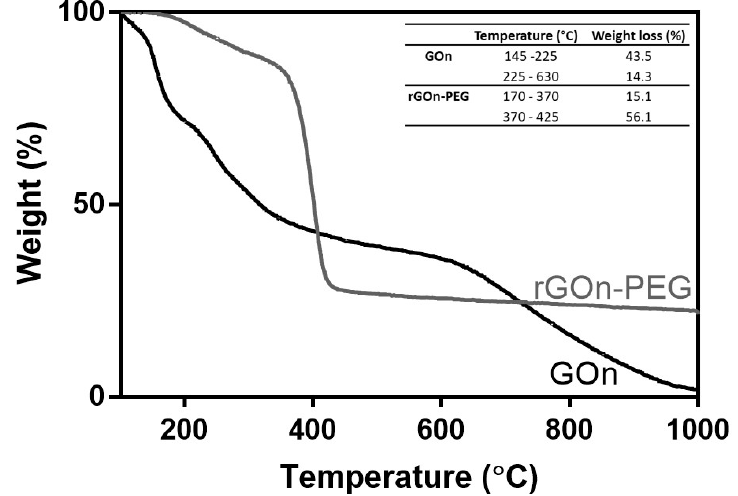
Figure 4. Thermal decomposition of GOn and rGOn-PEG. TGA curves and weight loss values for GOn (black line) and rGOn-PEG (grey line).